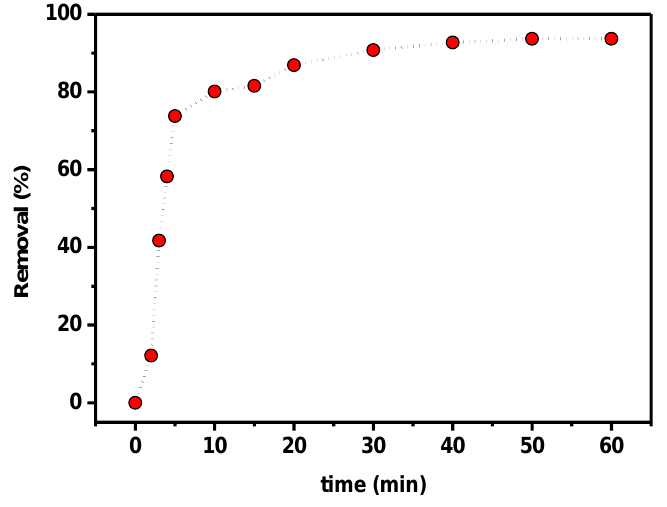
Figure 8. Effect of contact time on PTZS adsorption by GO-date Seeds (C 0 : 11 mg /L, T: 298K, pH: 9, Adsorbent dosage: 0.05 g /L, Contact time: 30 min).